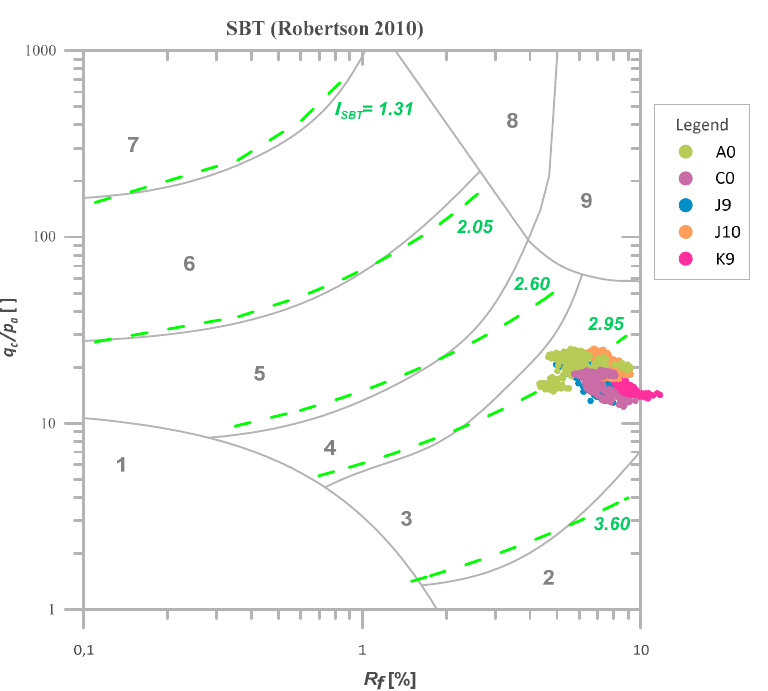
Figure 6. The values of I SBT for the selected homogeneous layer (3.0–5.0 m below the surface) for CPTs performed in Keswick clay [43] presented in the Robertson’s classification [44].